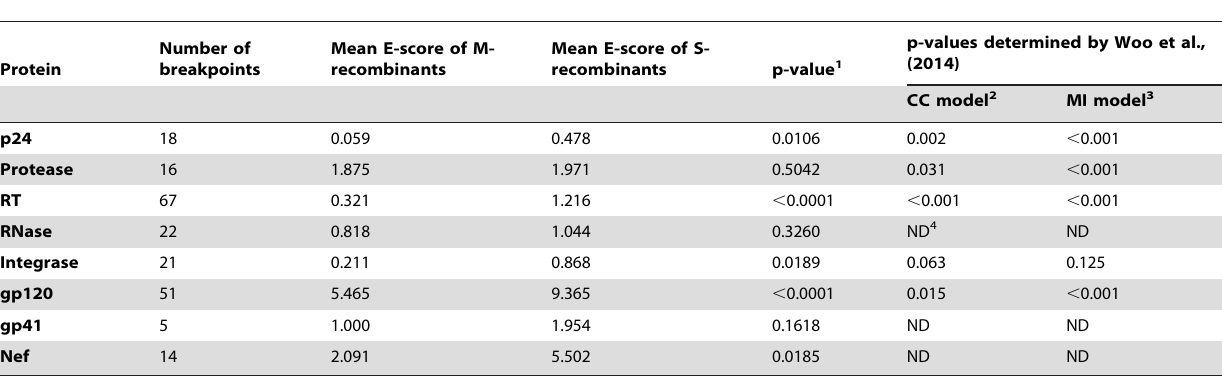
Table 2. Degrees of protein fold disruption in natural and simulated HIV-1 recombinants.